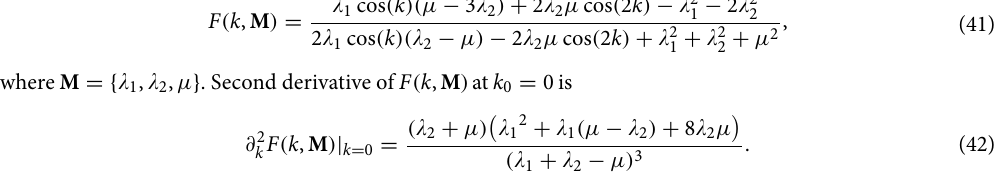
Figure 13. Behavior of correlation function (cid:31) R near the multi-critical point (cid:31) 1 1 with µ =